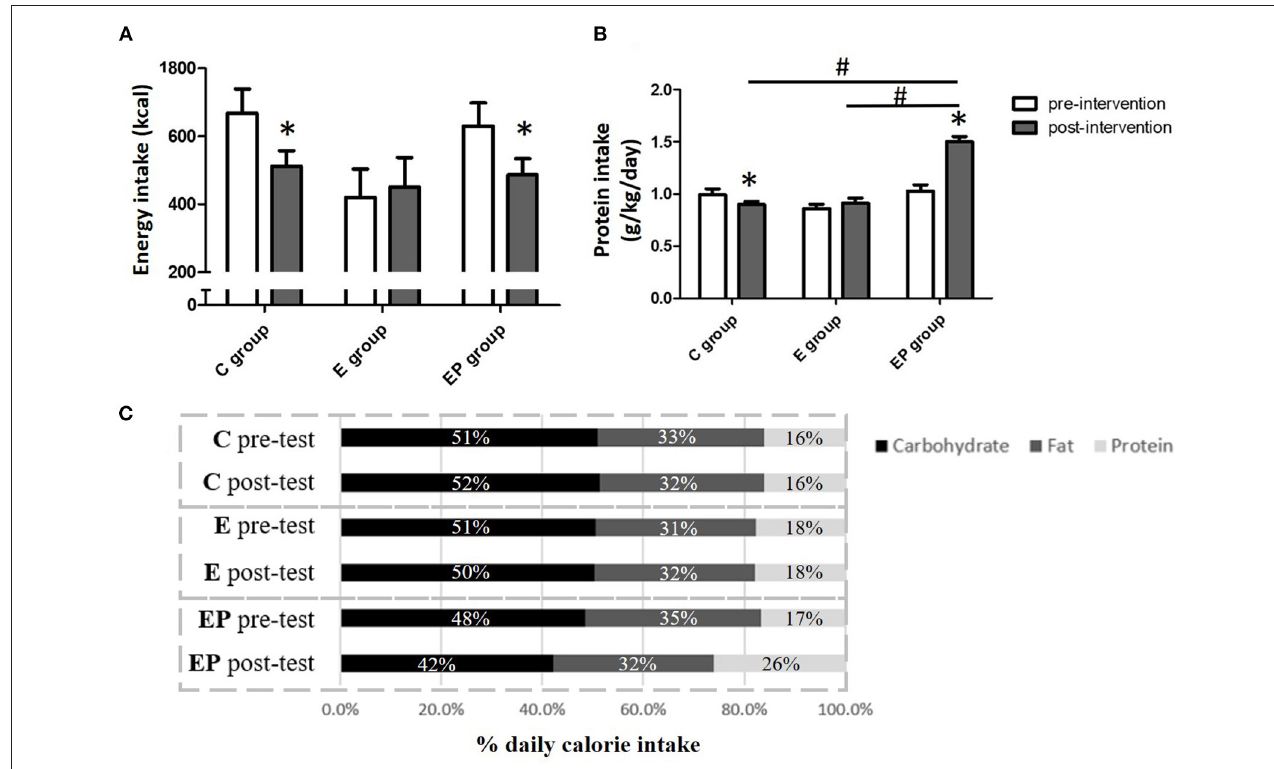
FIGURE 2 | Daily energy intake of participants before and after intervention. (A) Daily energy intake. (B) Daily protein intake. (C) The percentage of macronutrients of daily energy intake. Data were presented as mean ± SE or percentage. C, control group; E, exercise group; EP, exercise combined with high-protein diet group. *Significant change from the baseline. # Significantly different between